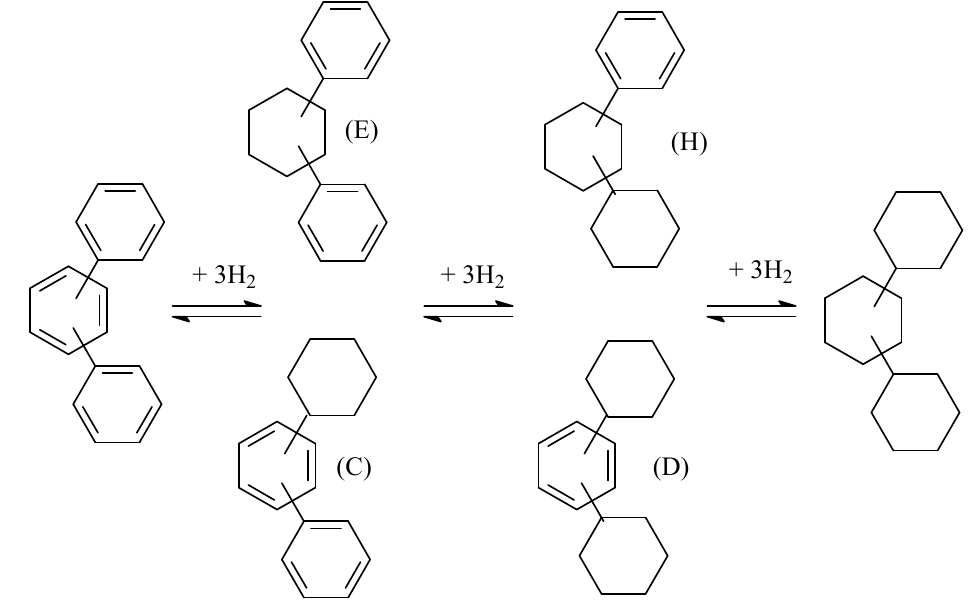
Figure 10. Possible ways of terphenyl hydrogenation.